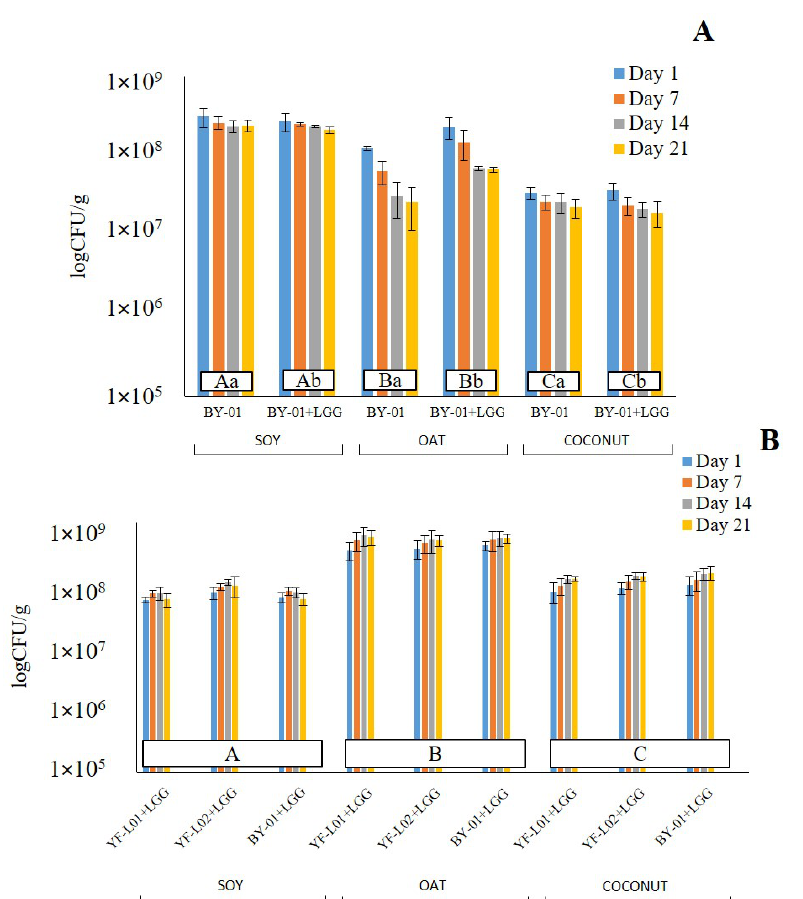
Figure 2. Viable cell counts of ( A ) BB-12 ® and ( B ) LGG ® in fermented soy, oat, and coconut bases in day 1, 7, 14, and 21 of storage at 6 ◦ C. ABC means with different uppercase superscripts indicate significant differences between different bases ( p < 0.05). ab means with different lowercase super- scripts indicate significant differences between different culture combinations ( p < 0.05). Since no significant difference between different cultures in each base was observed in the case of LGG ® CFU, only uppercase superscripts are